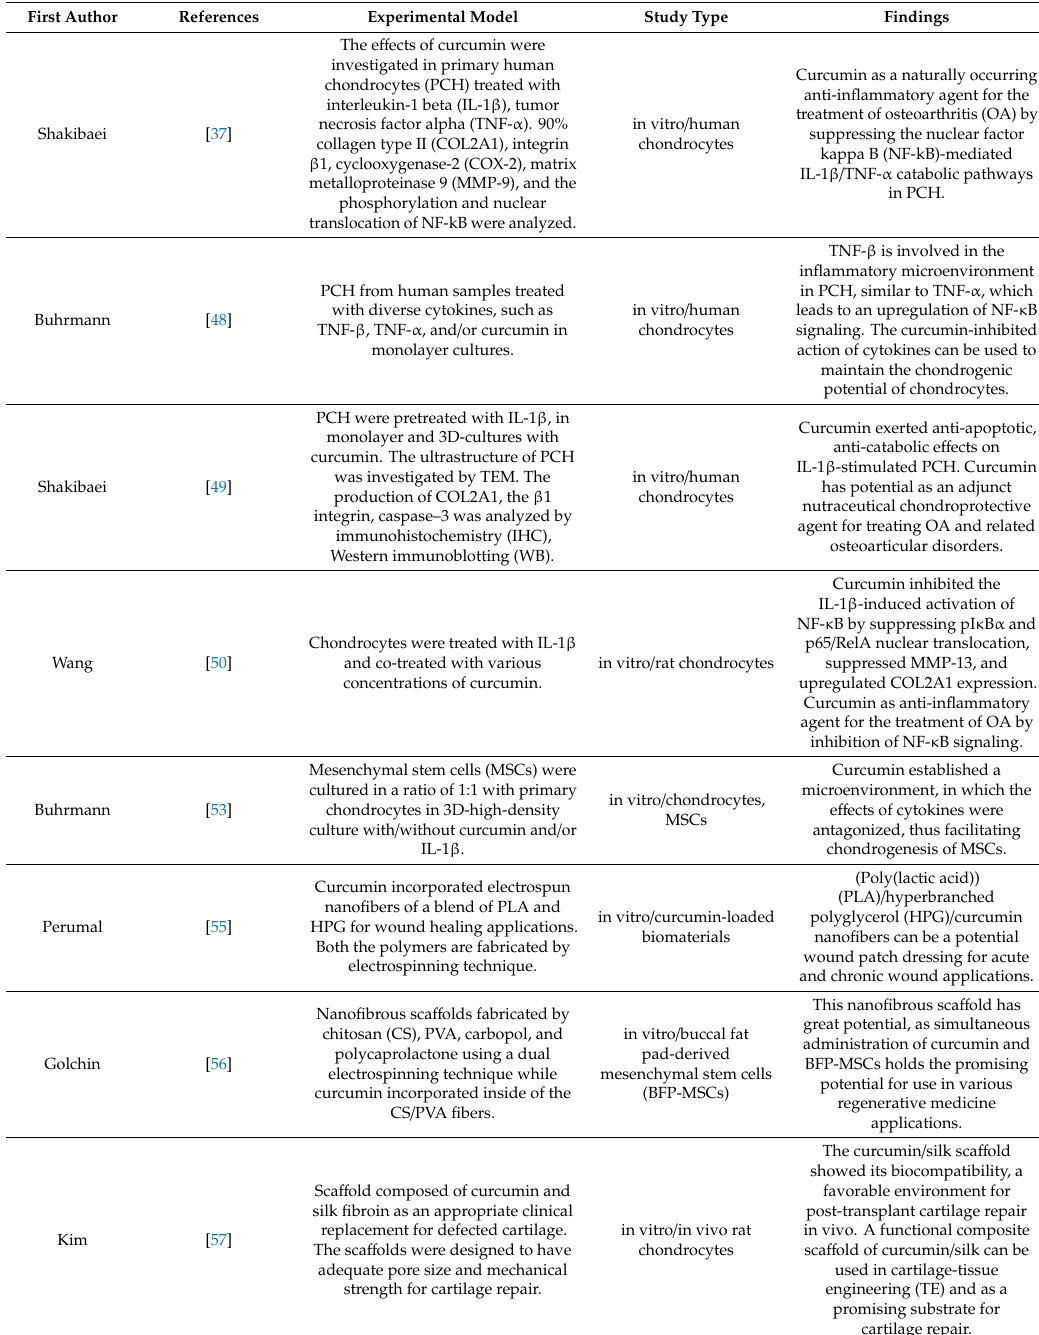
Table 1. Curcumin application in cartilage tissue